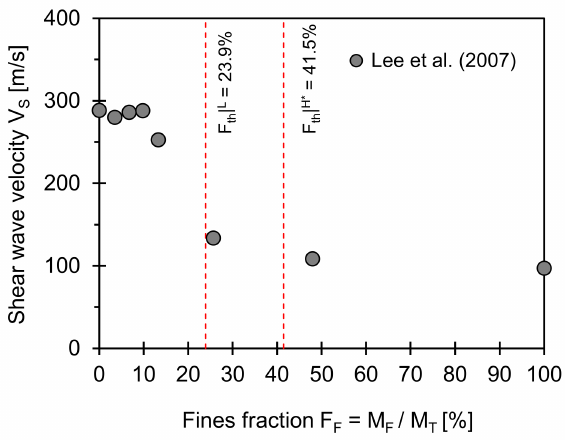
Figure 2. Shear wave velocity versus fines fraction. Two red dotted lines indicate low and data- adjusted high-threshold fines fractions computed using Equations (2) and (4). Input parameters used for estimation of two boundaries are e C max = 0.85, e C min = 0.59, e F max = 0.88; e F min = 0.56, and F th | L = 23.9%, and F th | H * = 41.5%. Note: Data extracted from Lee et al.